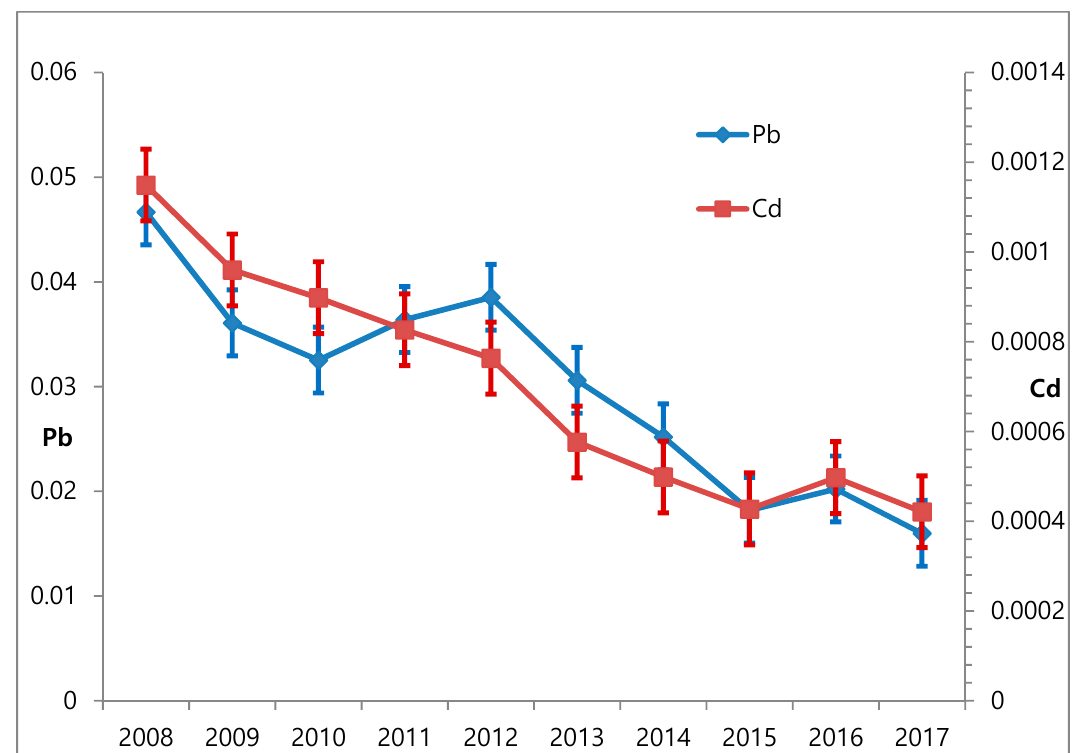
Figure 1. Changes of atmospheric GM concentrations of lead (Pb) and cadmium (Cd) from 2008 to 2017.